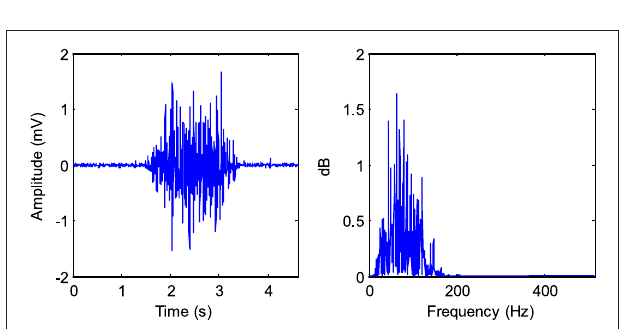
FIGURE 5 | A typical EMG signal and its power